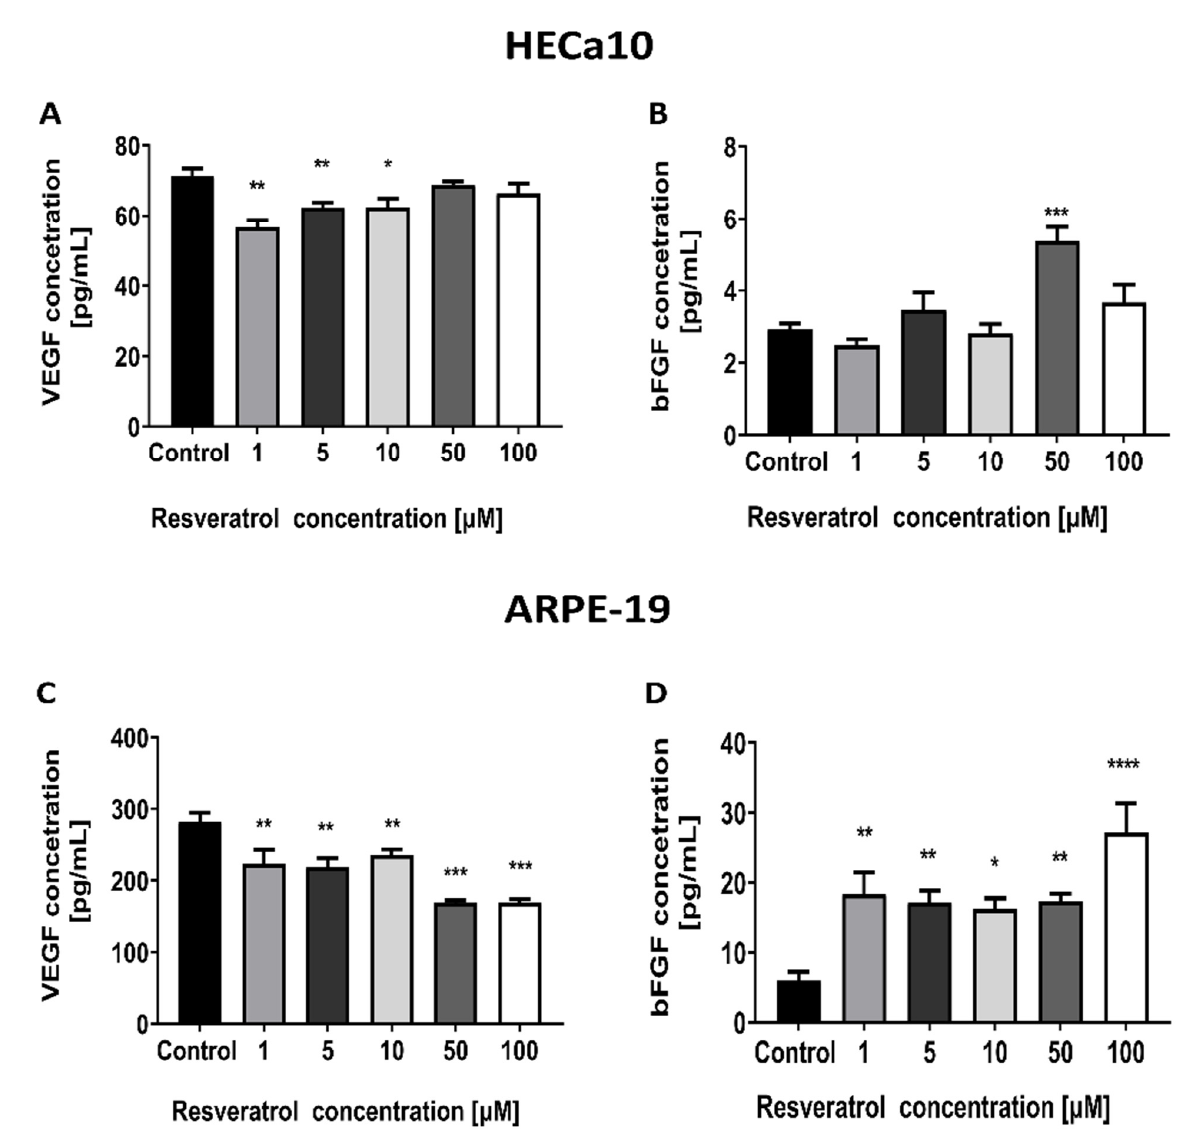
Figure 5. Secretion of angiogenic cytokines by the RSV treated HECa10 and ARPE-19 cells. VEGF and bFGF concentration in the supernatants from ( A , B ) HECa10 and ( C , D ) ARPE-19 cell lines cultures after 24 h treatment with RSV at 1, 5, 10, 50, and 100 µ M were measured using ELISA test. Control cells were cultured with 0.1% DMSO and without RSV. The results are presented as mean ± SD in at least three experiments with * p < 0.05, ** p < 0.01, *** p < 0.001, **** p < 0.0001 compared to the control.